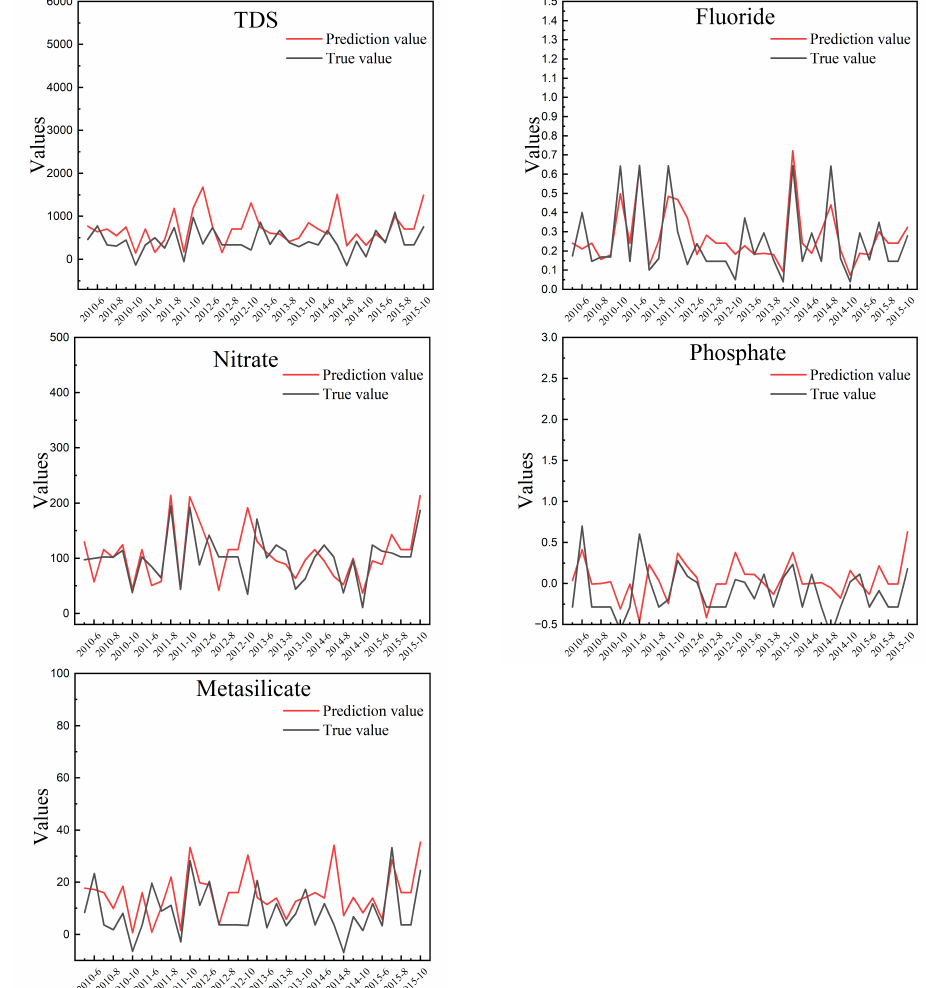
Figure 4. Prediction values and true values for the five indicator concentrations in the rainy